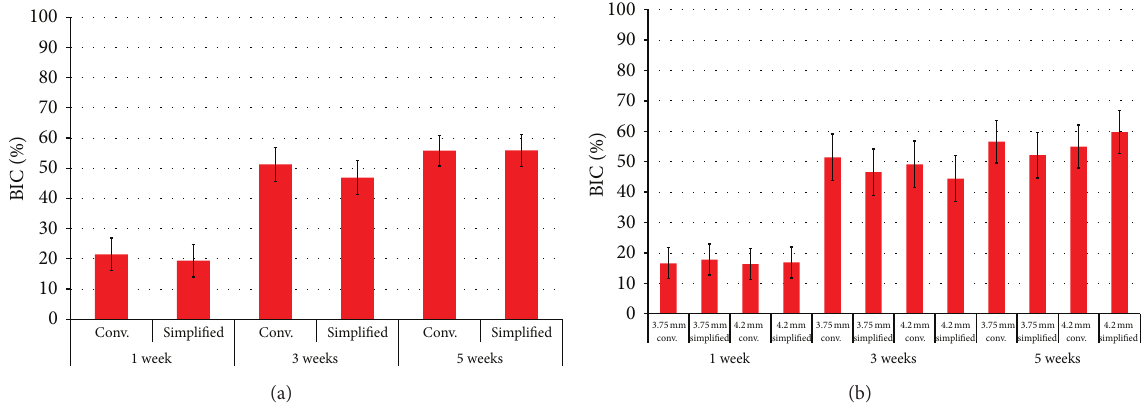
Figure 1: (a) Results for bone-to-implant (BIC) (mean ± 95% CI) as a function of drilling technique and time in vivo where no significant differences were observed between groups for each time point in vivo . (b) Results for BIC (mean ± 95% CI) as a function of drilling technique, time in vivo , and implant diameter. No significant differences were observed between groups for each time point in vivo